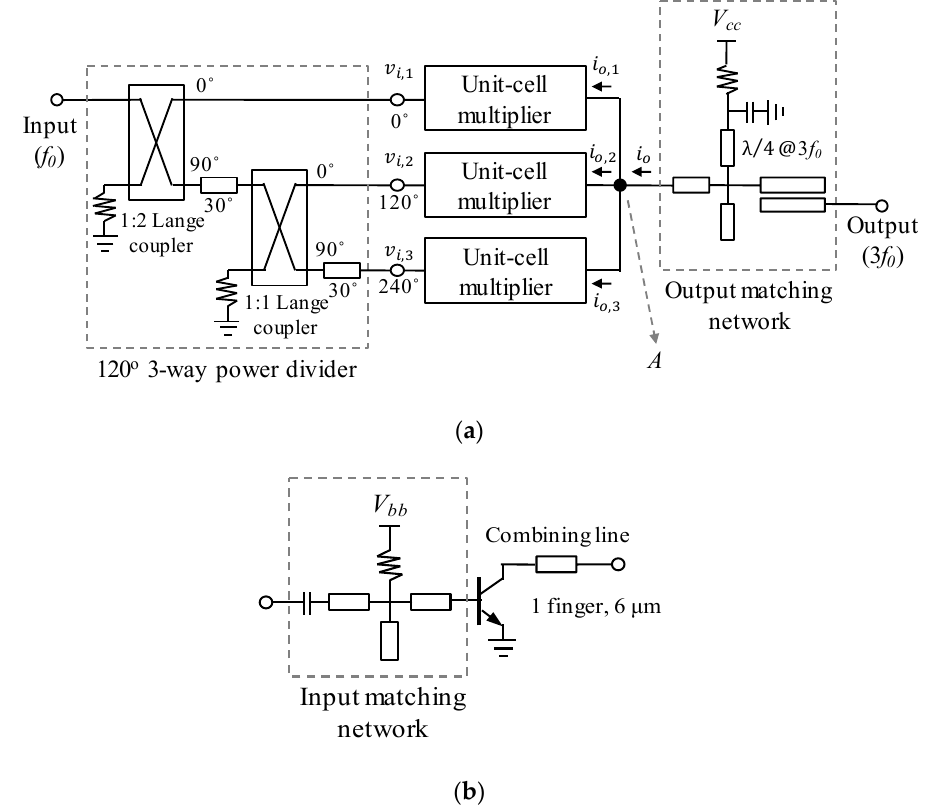
Figure 1. Designed H -band frequency tripler based on the triple-push technique. ( a ) Entire tripler; ( b ) unit-cell multiplier.